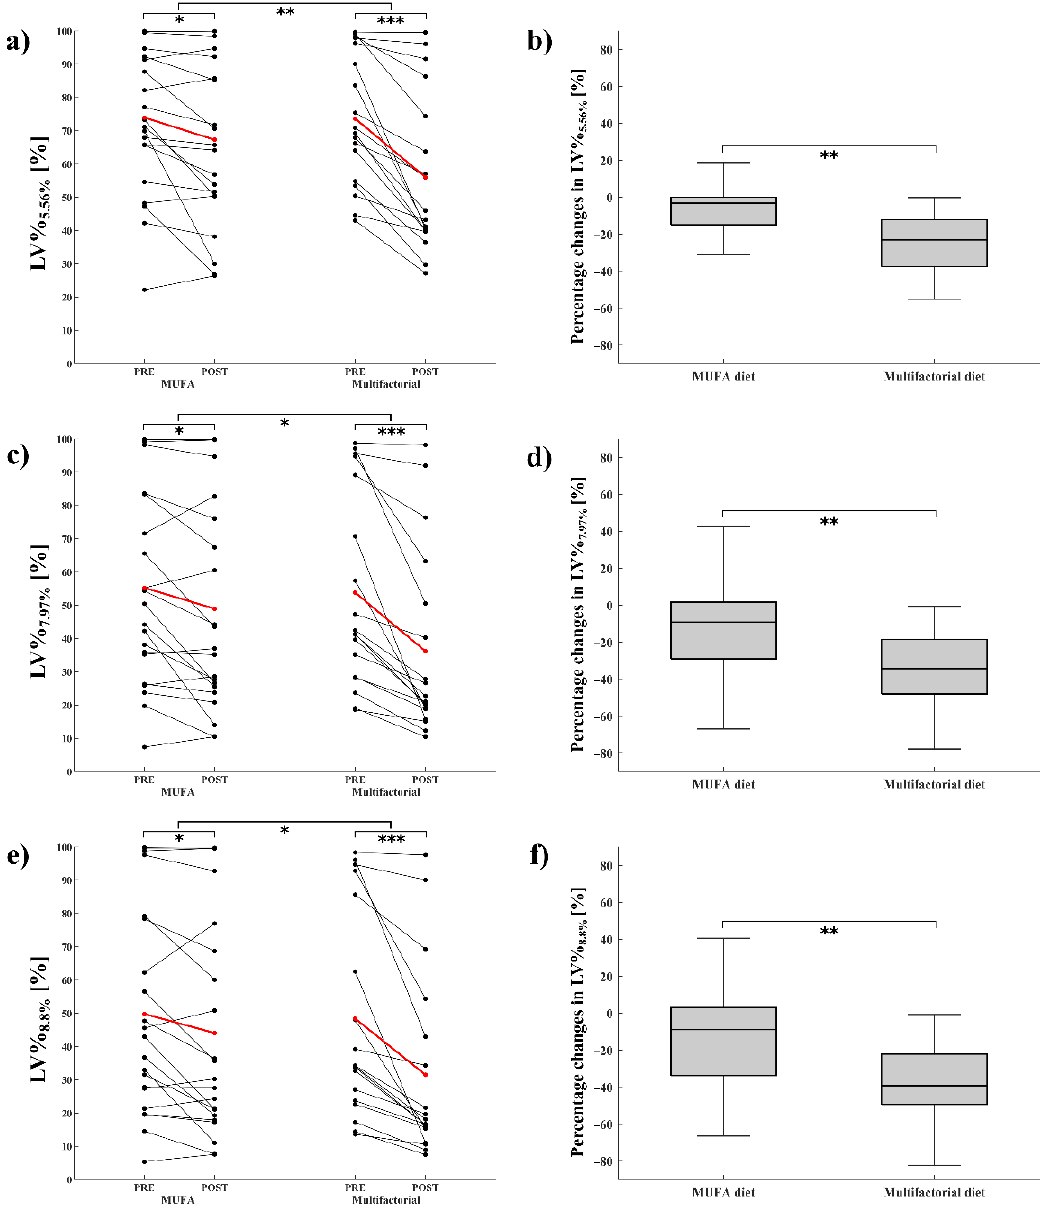
Figure 3. Absolute individual changes (left side) and percent changes (right side) in percentage of volume above thresholds for steatosis after the 8-week intervention with MUFA diet or multifactorial diet. Steatosis thresholds were set at 5.56% ( a , b ), 7.97% ( c , d ), and 8.8% ( e , f ). Asterisks indicates statistically significant differences (* = p < 0.05; ** = p < 0.005; *** = p < 0.0005). Abbreviations: MRI = Magnetic Resonance Imaging; PDFF = Proton Density Fat Fraction; VOI = Volume of Interest; and WL = Whole Liver.